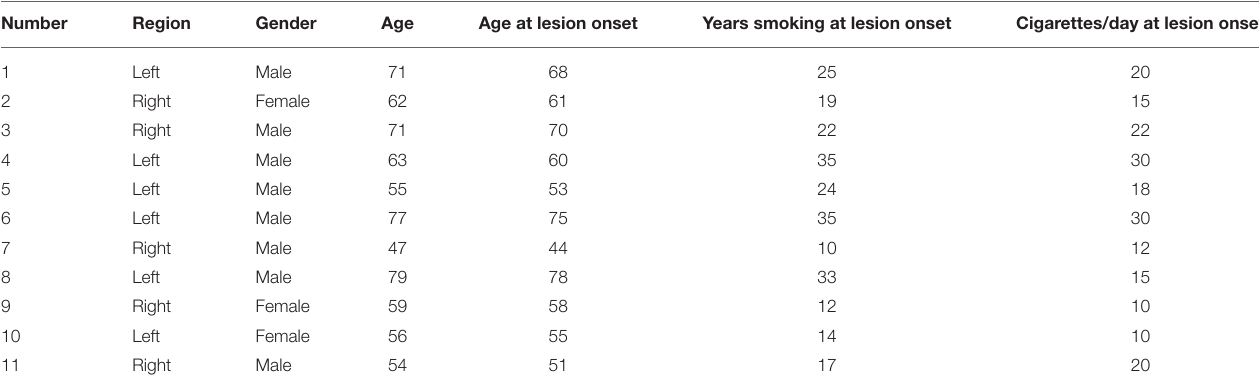
TABLE 1 | Detailed information about patients who acquired dorsal striatum damage.